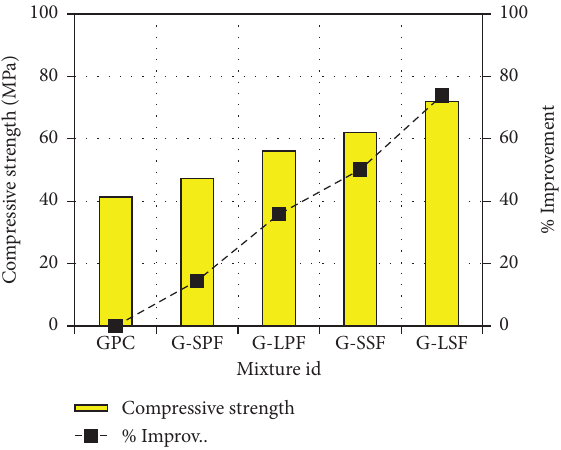
Figure 7: Compressive strength of specimens. Table 4: Fracture test results of nonfbrous and fbrous